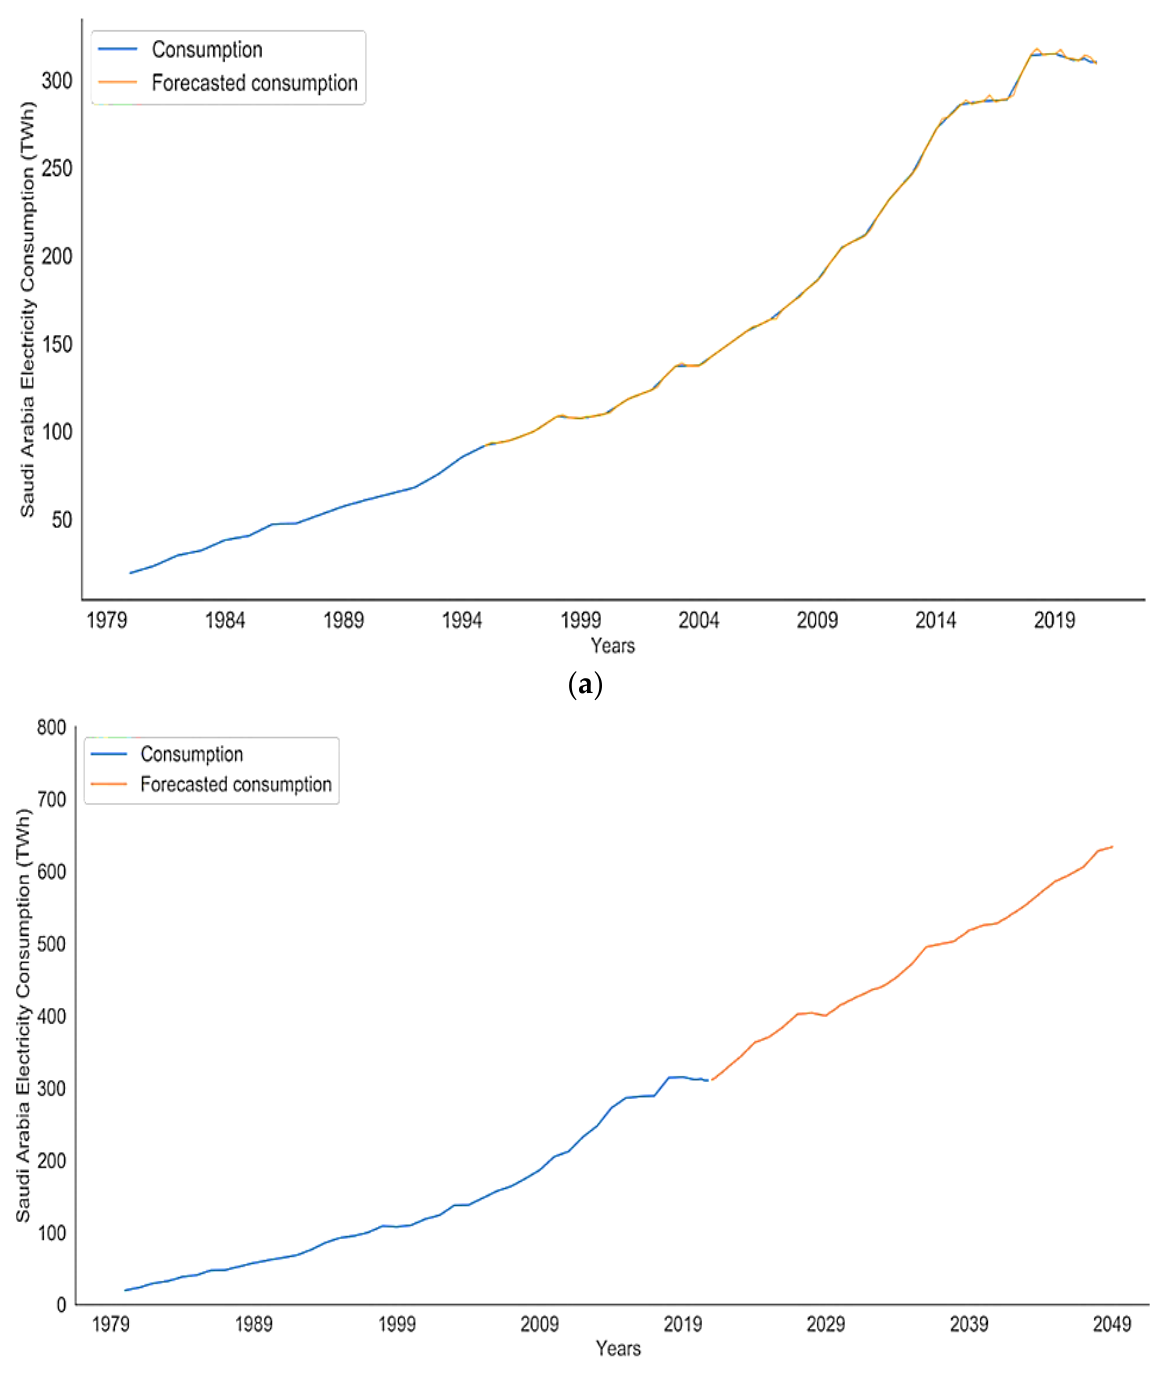
Figure 6. ( a ) Real and forecasted values of electricity generation, which show the good fit and per- formance of the SARIMAX model. ( b ) Forecasted electricity generation values for the 30-year period from 2021 to 2050.